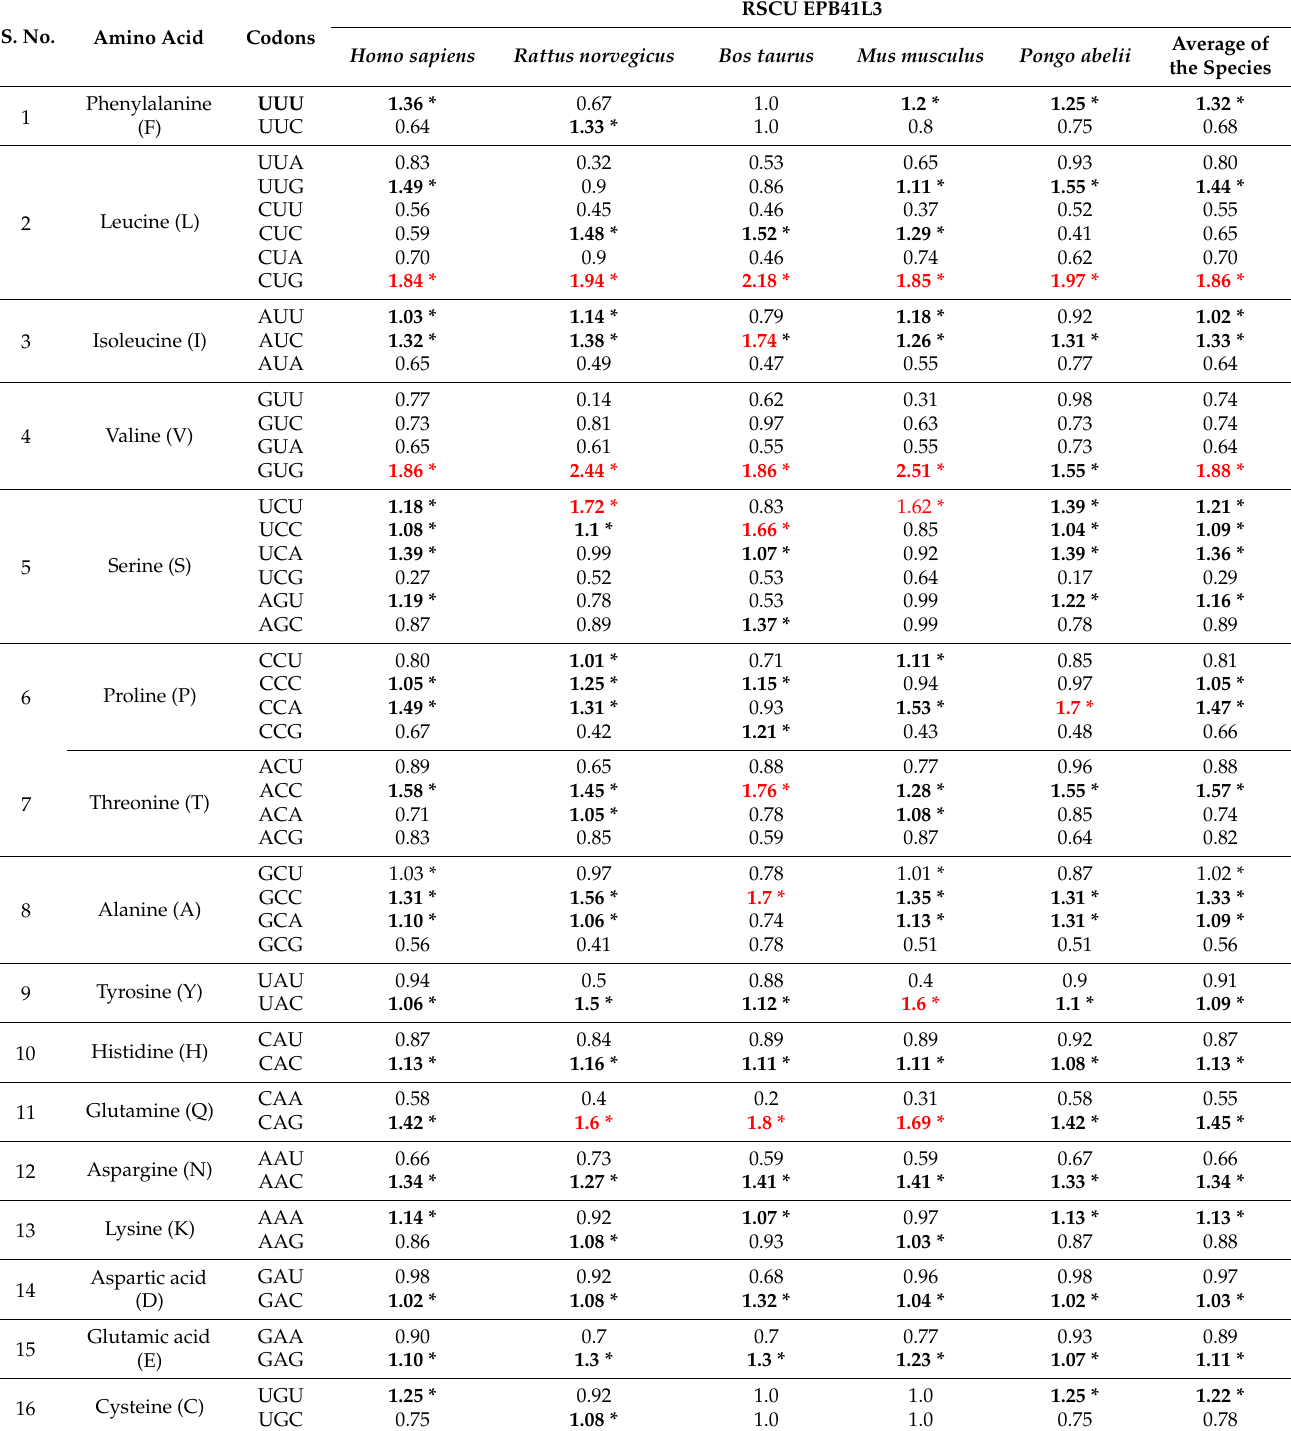
Table 1. Relative synonymous codon usage (RSCU) analysis of the various codons of all the 34 coding sequences of the EPB41L3 gene of the selected mammalian